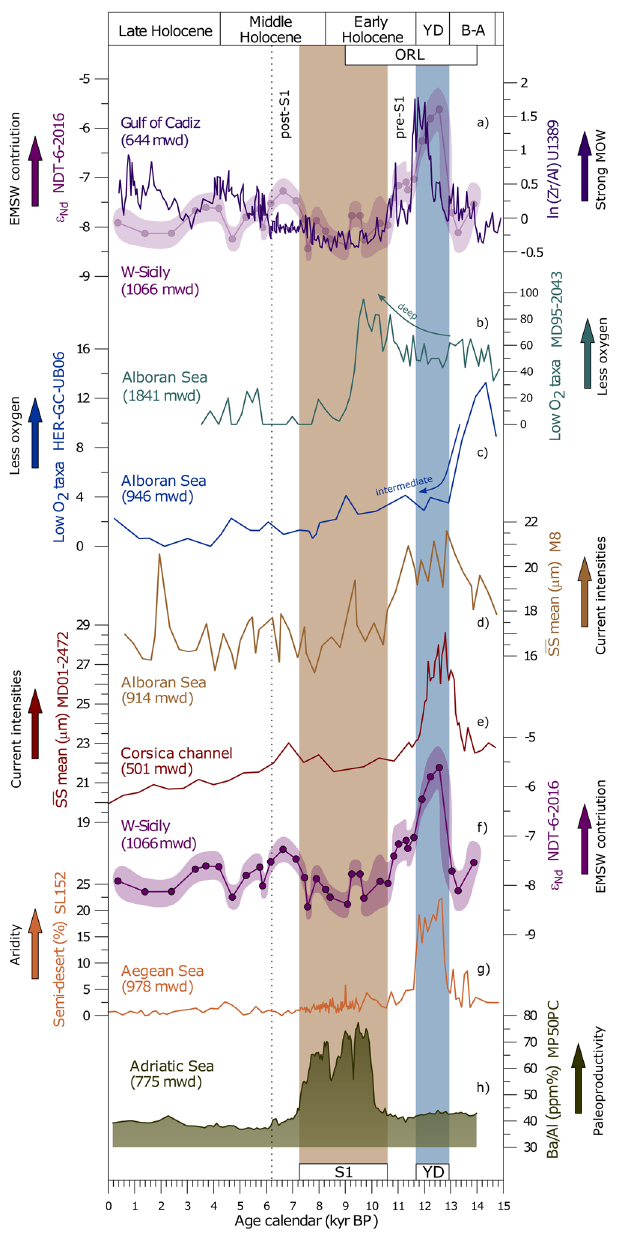
Fig. 4 Comparison between marine records from the Mediterranean region. From the top to the base: ( a ) Zr/Al from U139 6 . b , c Low oxygen benthic foraminiferal taxa percentages from intermediate record HER-GC- UB6 and deep MD95-2043 67 respectively. d , e Grain-size measurements from M8 64 and MD01-2472 87 respectively. f Neodymium isotope records from NDT-6-2016 (this study). g Semi-desert taxa percentages obtained from SL152 24,88 . h Ba/Al pro fi les from MP50PC 34 . Grey-blue bar represents the YD and light-brown bar the